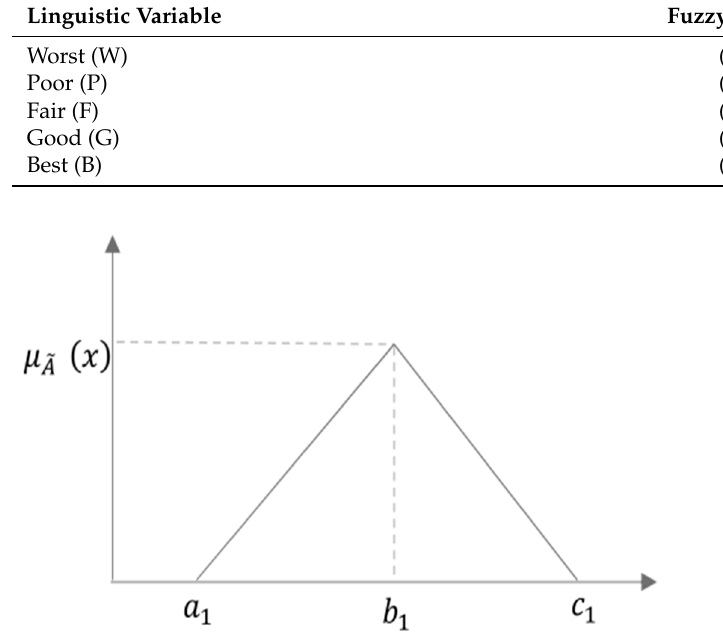
Figure 5. Triangular fuzzy number